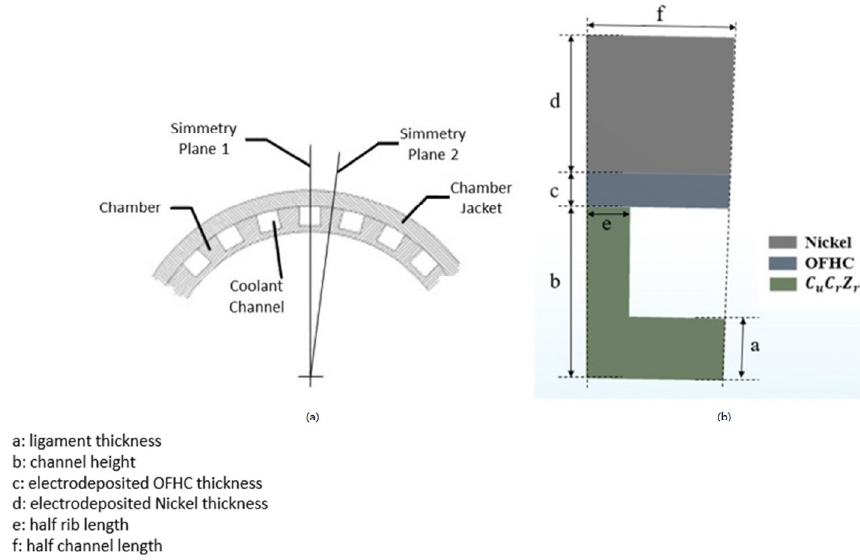
Figure 5. Highlight of symmetry conditions ( a ) and cooling channel section ( b ) [5].